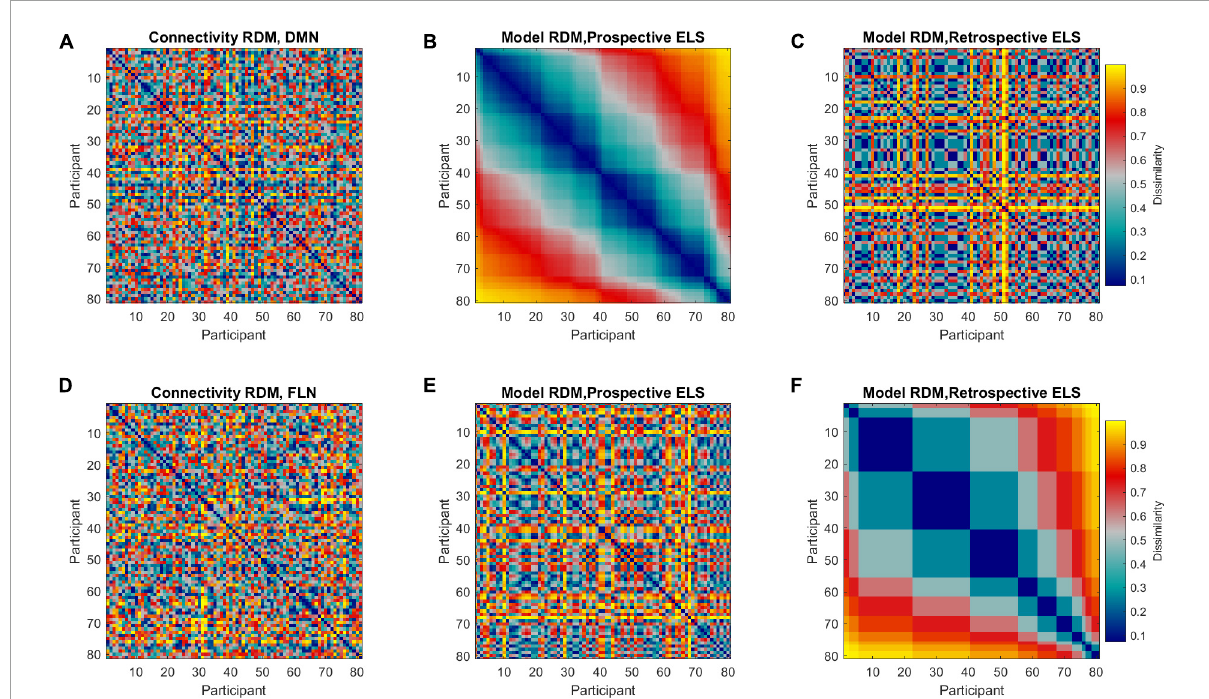
FIGURE3 Representational dissimilarity matrices (RDMs) representing dissimilarities between all pairwise comparisons across all participants (81 × 81, n = 86, 5 outliers removed). Colors indicate the extent of dissimilarity between participants, where dark blue represents maximum similarity and yellow represents maximum dissimilarity. Representational dissimilarity matrices are displayed for DMN (A) and FLN (D) connectivity profiles, prospective ELS (B,E) , and retrospective ELS (C,F) . Note that matrices (A–C) are sorted according to prospective ELS, and matrices (D–F) are sorted according to retrospective ELS.